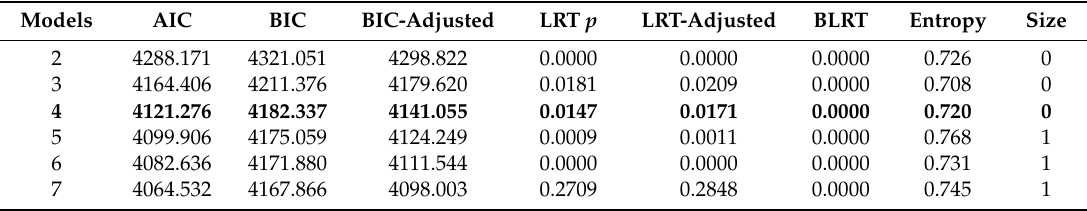
Table 2. The fit of the all latent profiles models.